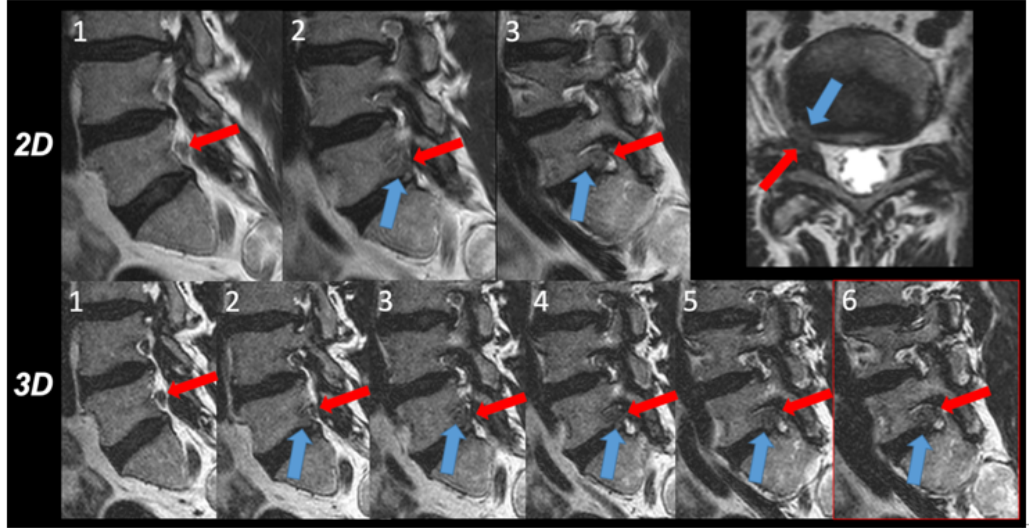
Figure 3. Intra-individual comparison of the 2D and 3D images. The relationship between disc her- niation (blue arrow) and nerve root (red arrow) within the intervertebral foramen right side was evaluated in three consecutive 2D T2w TSE images (upper row 1 to 3) and in six 3D T2w TSE images (lower row 1 to 5) depicting each third to fourth image. In 2D T2w TSE images, contact between the disc herniation and the nerve root is depicted in images 2 and 3, however, no nerve root compression was appreciated. In 3D T2w TSE images, however, a compression of the nerve root due to the intra- foraminal disc herniation was obvious in images 3 to 6 and verified in the transverse thin slice refor- matted image.